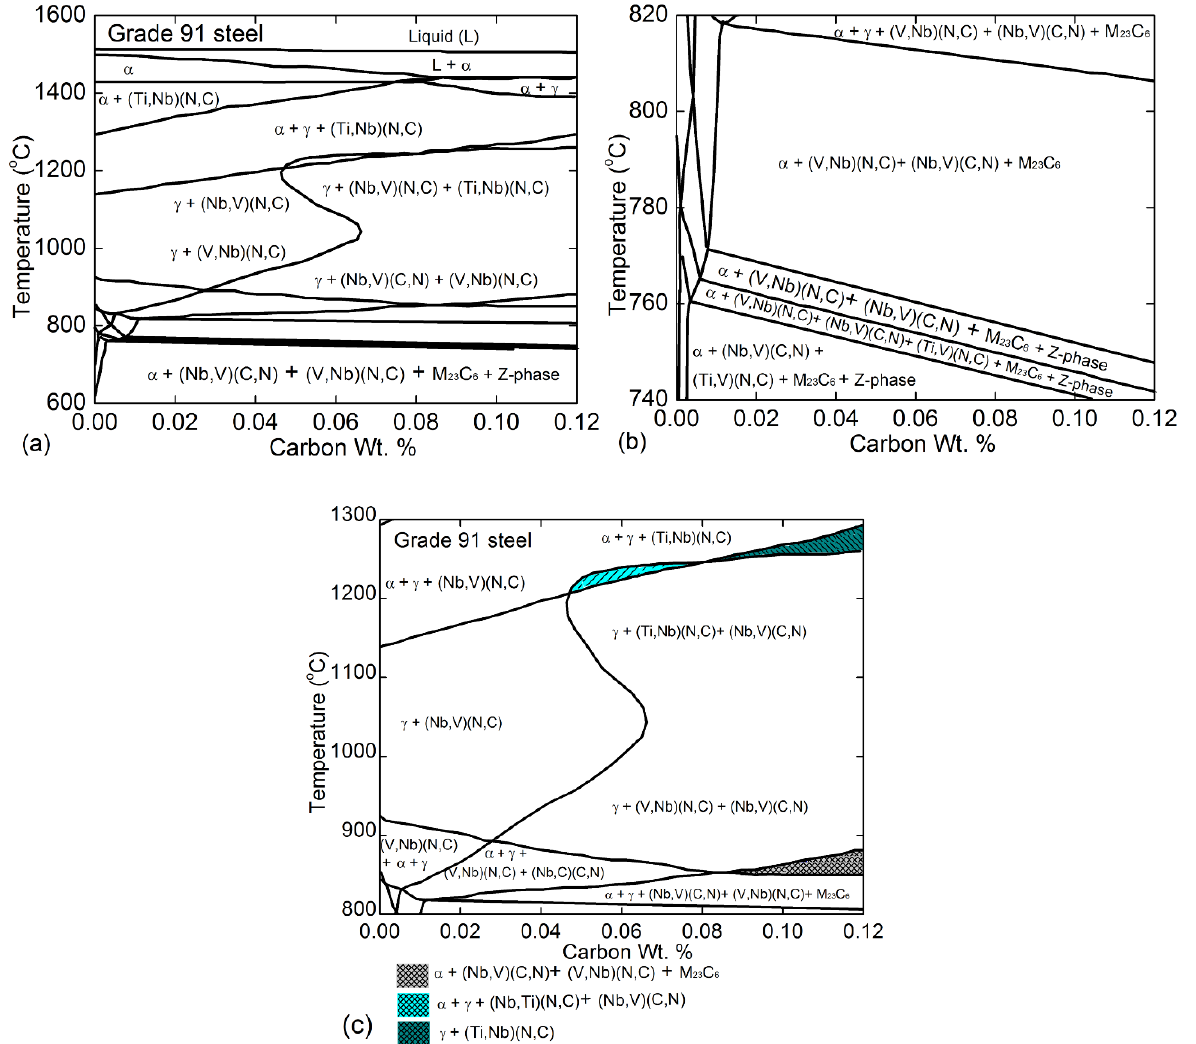
Figure 6. Carbon isopleth for Grade 91 steel. ( a ) Complete diagram: 600–1600 °C; ( b ) 740–820 °C; ( c ) 800–1300